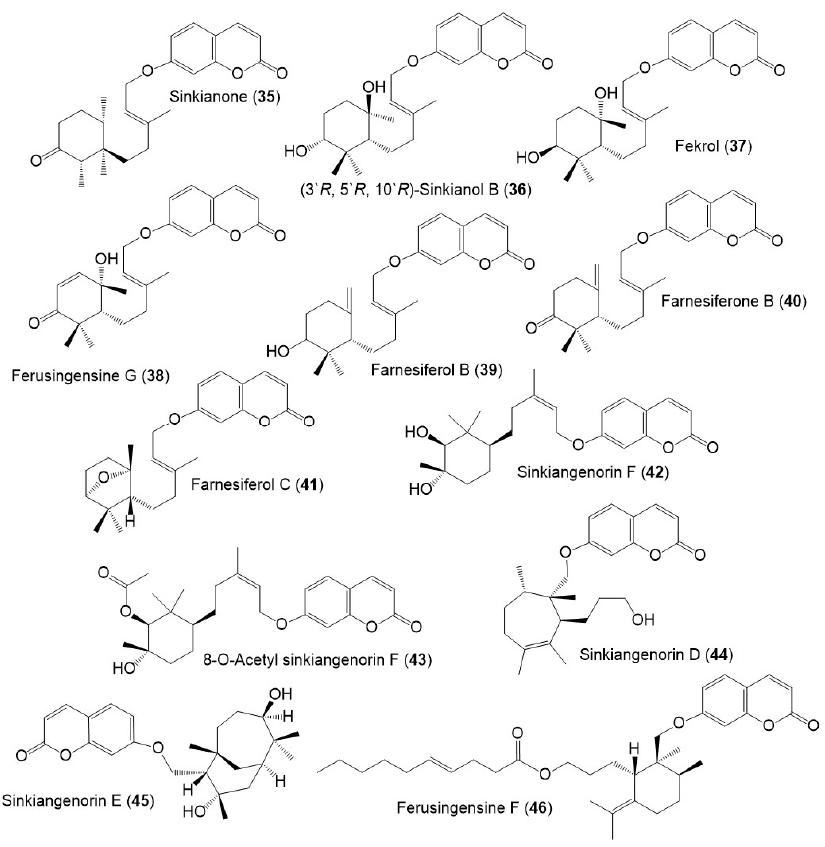
Figure 6. Structures of sesquiterpene coumarins ( 35 – 46 ) reported from F. sinkiangensis .